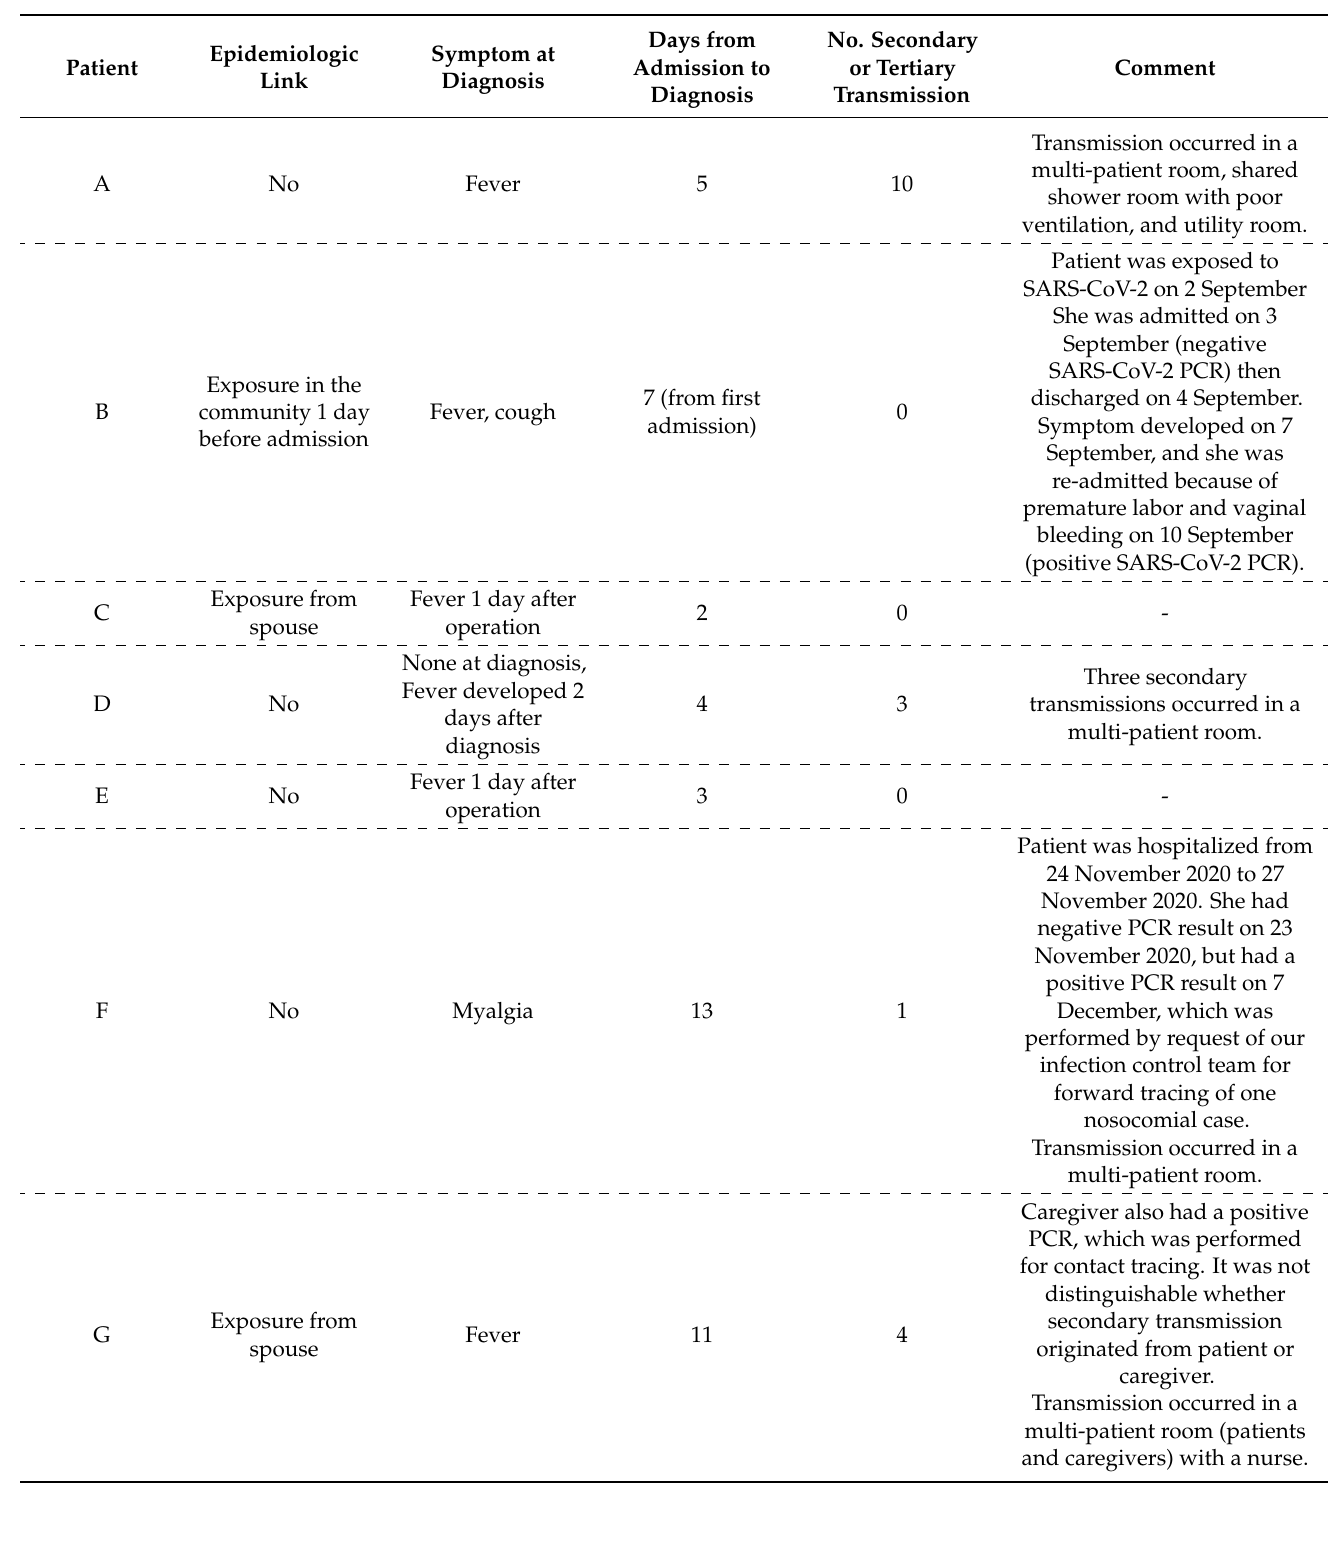
Table 1. Characteristics of patients who had negative pre-admission SARS-CoV-2 PCR testing but had a positive test during hospitalization or after